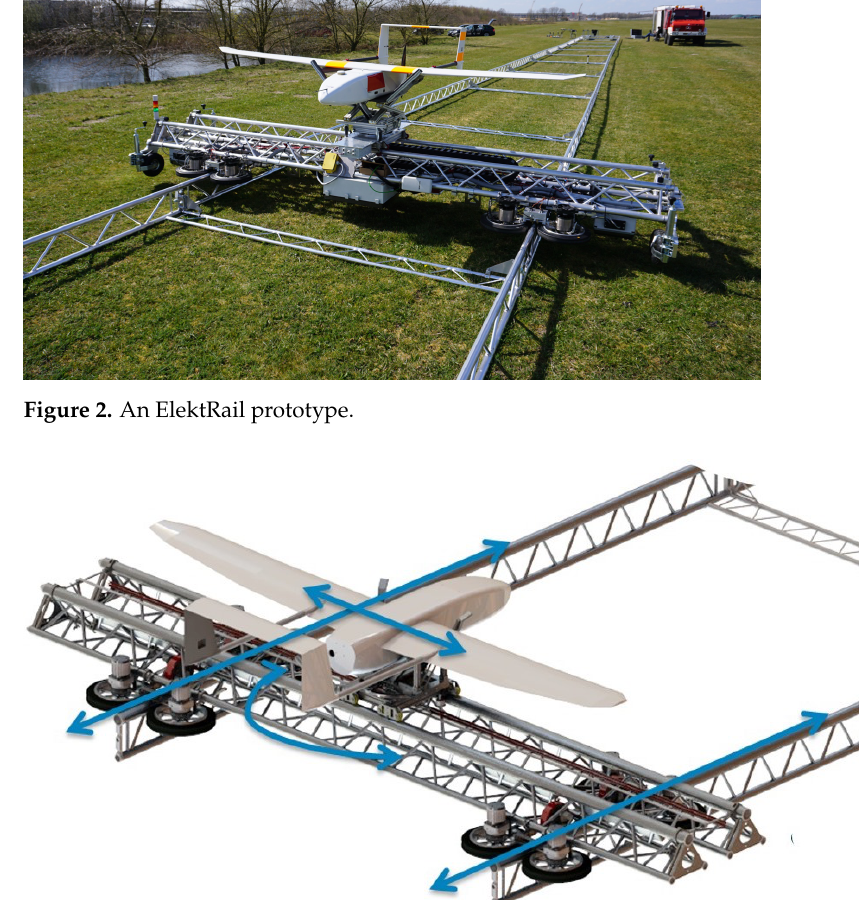
Figure 3. An ElektRail CAD